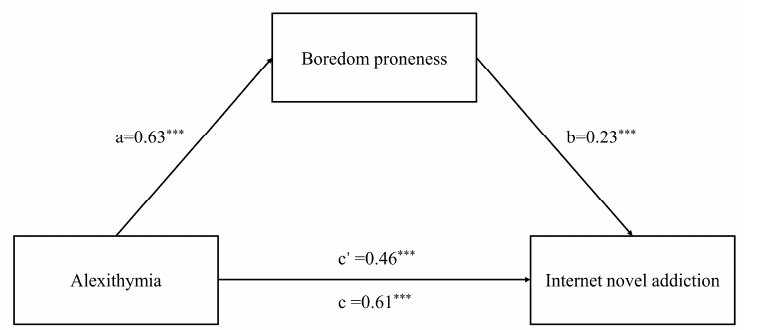
Figure 1. Mediation model between alexithymia, boredom proneness, and internet novel addiction. Note: *** p <